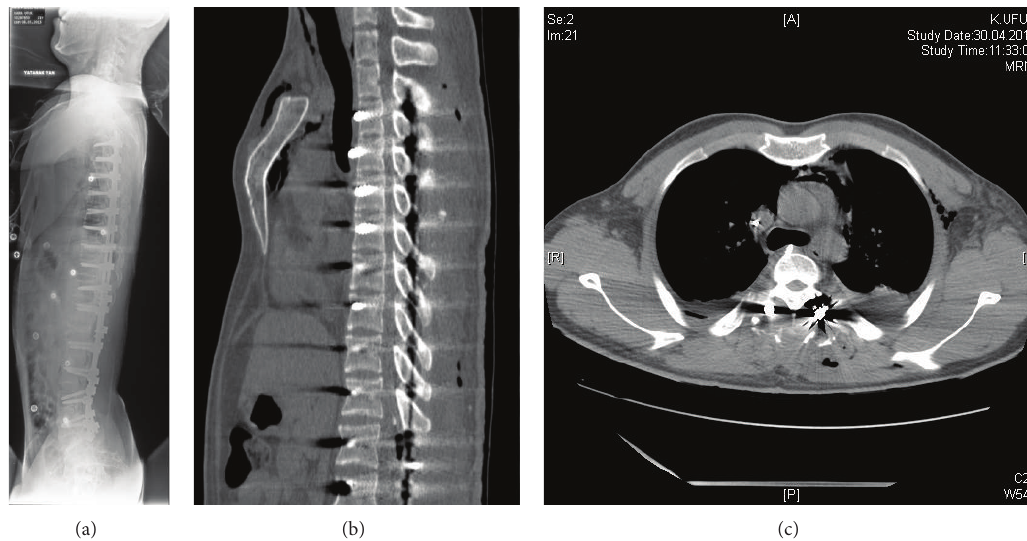
Figure 2: Contusion of the trachea at the carina level by the right T3 pedicle screw.